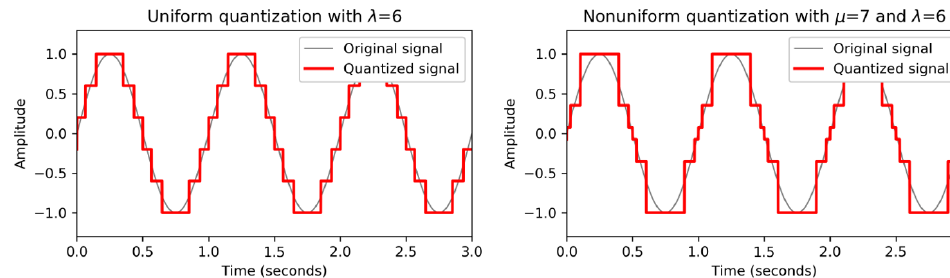
Figure 9. Uniform and nonuniform quantization (based on µ -law encoding) using λ = 6 quantiza- tion